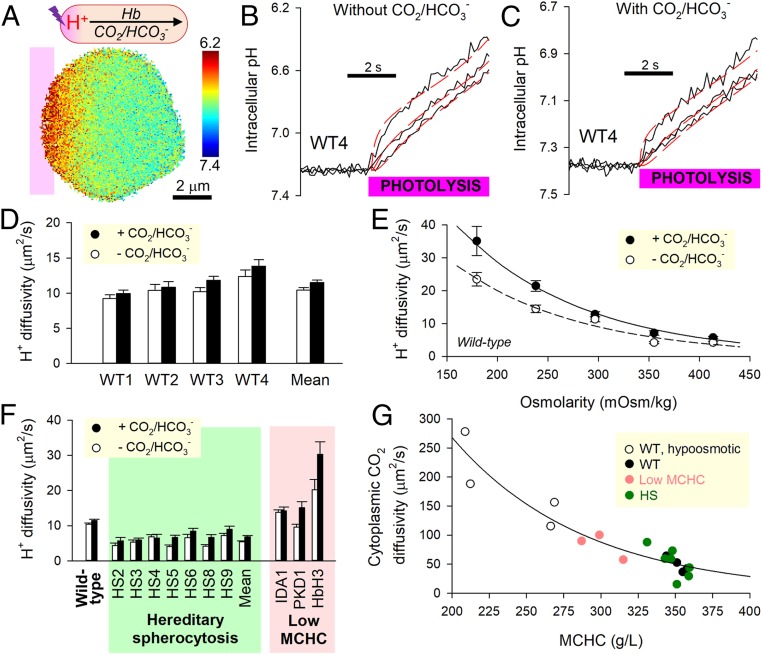
Measuring CO2 diffusivity in RBC cytoplasm. (A) Photolytic uncaging of H+ ions from NVA at one end of a wild-type (WT) RBC produces an acidic microdomain that dissipates diffusively across cytoplasm, facilitated by Hb and (if added) CO2/HCO3− buffer. (B) Measurements in the absence of CO2/HCO3−; time course of pHi (black trace) in 10 equally spaced ROIs across the width of a WT RBC. Traces for ROIs 1, 4, and 7 are shown for clarity. Best fit (red) to diffusion model for deriving H+ diffusivity, DHapp. (C) Protocol performed under superfusion with CO2/HCO3−. (D) Summary data from four WT samples (n = 226 WT cells). (E) Relationship between osmolarity (varied by adding or removing NaCl) and DHapp in WT RBCs (n = 30 to 50 per bar). (F) Summary data from HS blood and three samples of reduced MCHC: iron deficiency (IDA1), puryvate kinase deficiency (PKD1), and HbH thalassemia (HbH3). Mean ± SEM (n = 20 to 35). (G) Relationship between MCHC and cytoplasmic CO2 diffusivity calculated from DHapp measured in the presence and absence of CO2/HCO3−.